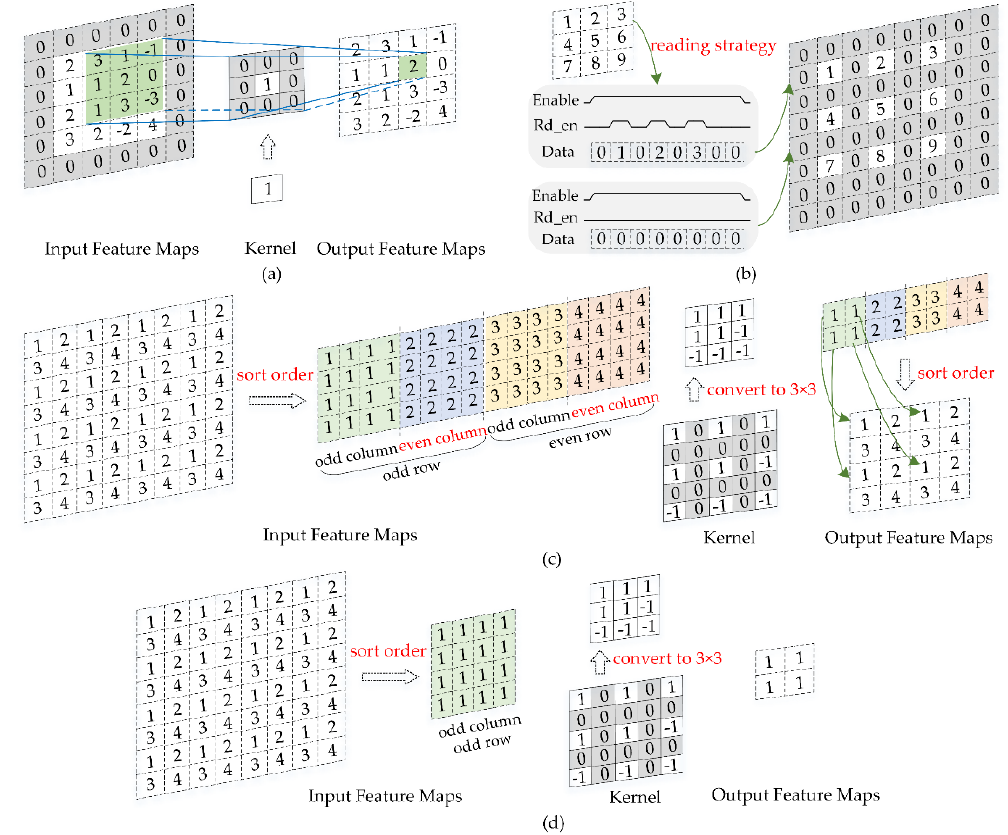
Figure 7. ( a ) The schematic diagram of the modified 1 × 1 convolution operation process. ( b )The interpolation processing of the input feature map. If the row contains feature values, we will read the feature values and zero at intervals according to the interpolation rules; otherwise, the readout values are all equal to zero. ( c ) The modified computational process of the dilated convolution with a 1-pixel stride. ( d ) The modified computational process of the dilated convolution with a 2-pixel stride.